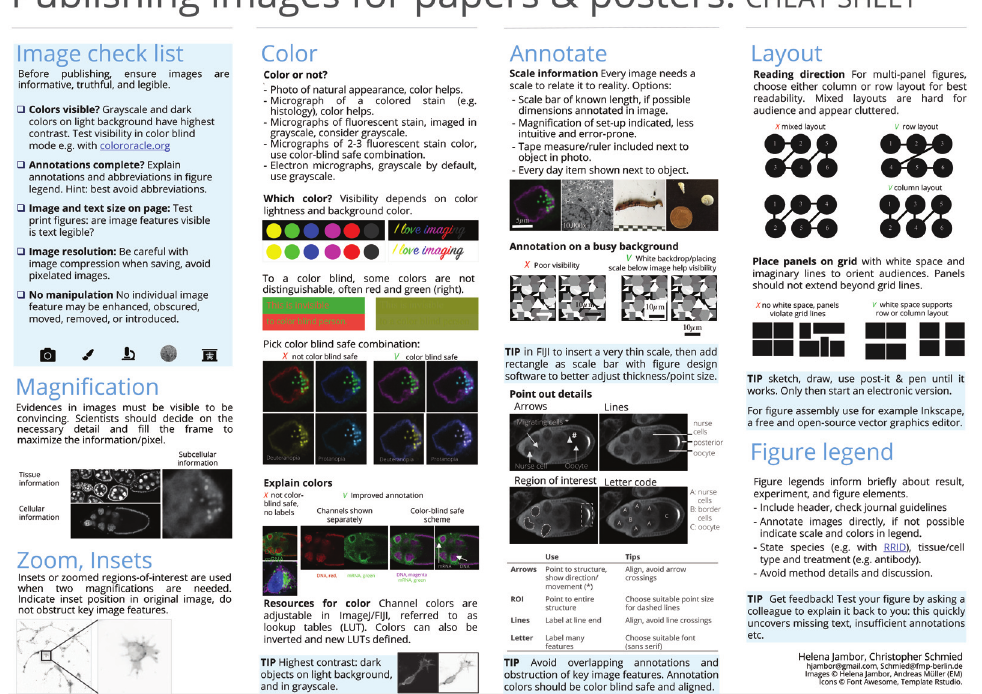
Figure 4. Cheat sheet 2: publishing images for papers and posters 45